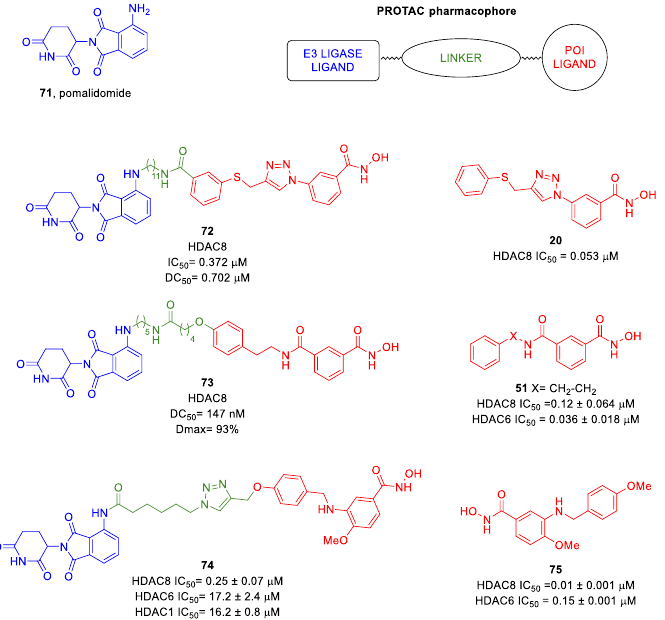
Figure 13. Representation of reported HDAC8-degraders and HDAC8-inhibiting precursors [142,143,160,187 –